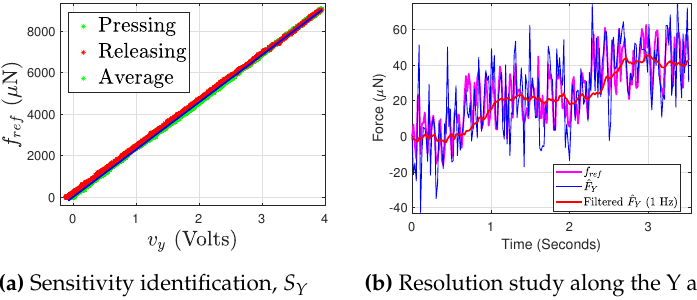
Figure 12. Characterization of PRT along Y.